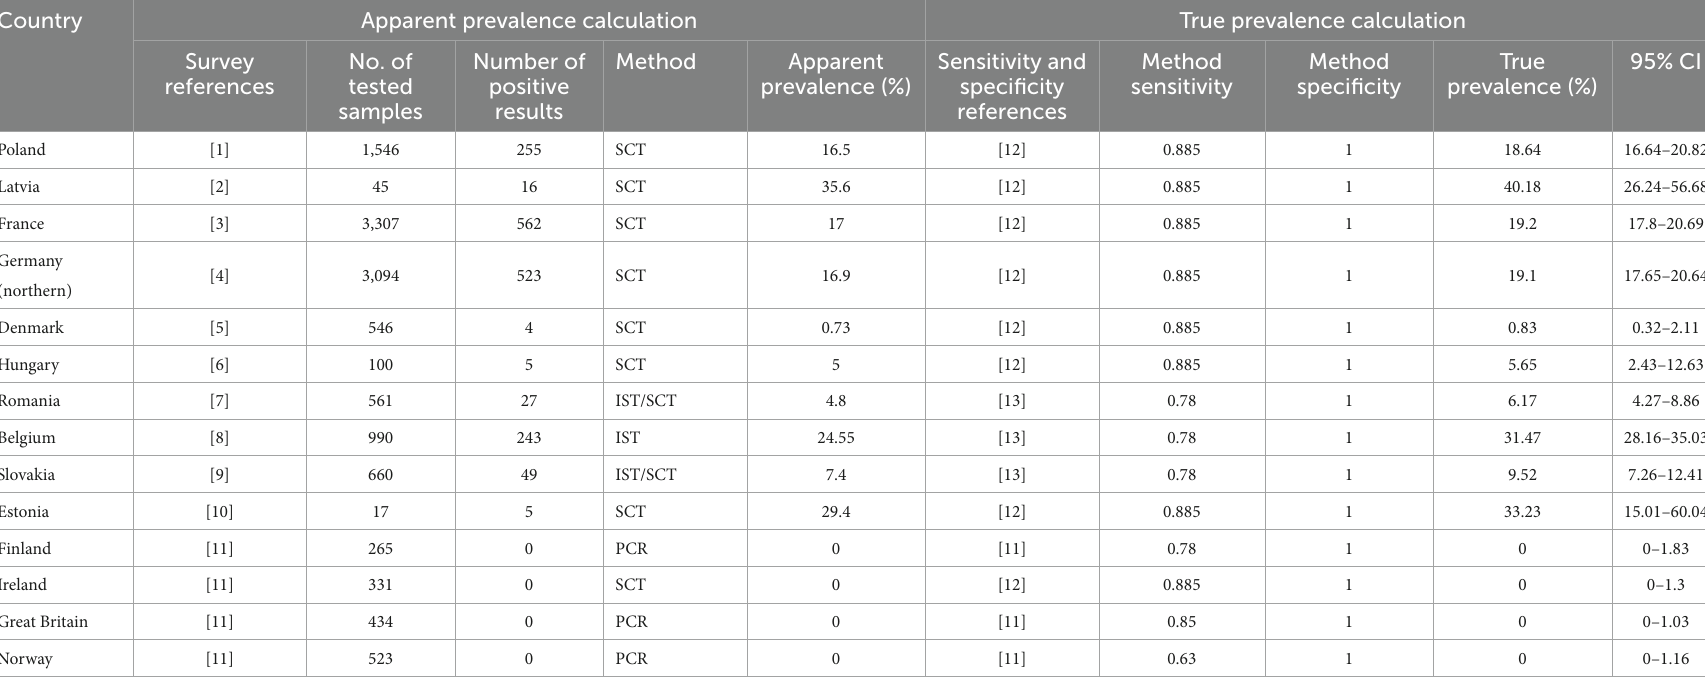
TABLE 3 Calculation of the true prevalence of E. multilocularis in red foxes in selected European countries.